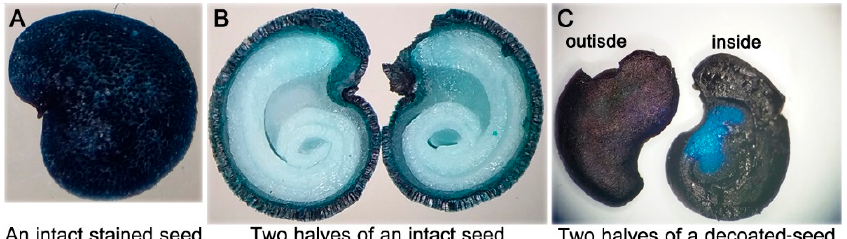
Figure 3. Testing water permeability potential of wild M. autumnalis seeds with the methylene blue assay. ( A , B ) intact seeds tested monthly for up to five months showed almost no penetration of the blue stain into the enclosed tissues of the endosperm and embryo; ( C ) seed coat removal resulted in fast and complete staining of the endosperm and most of the embryo within 6 days. Photos of non-stained intact seed and decoated seed, and of an isolated zygotic embryo are shown in Figure 1D